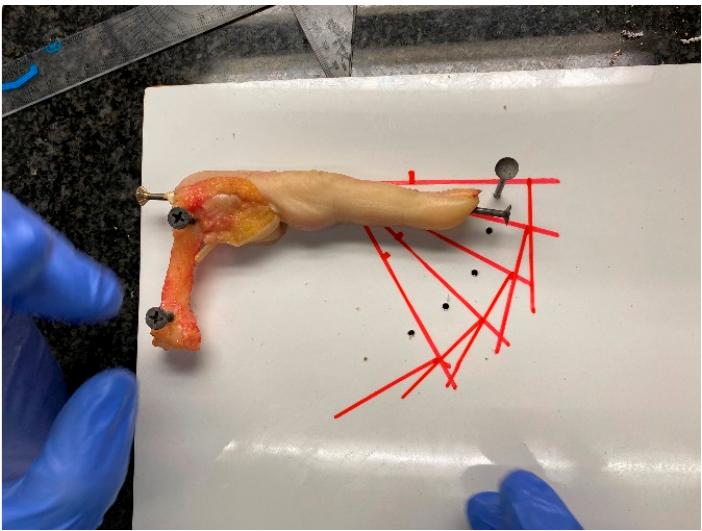
Figure 2. Anatomy lab evaluation model.